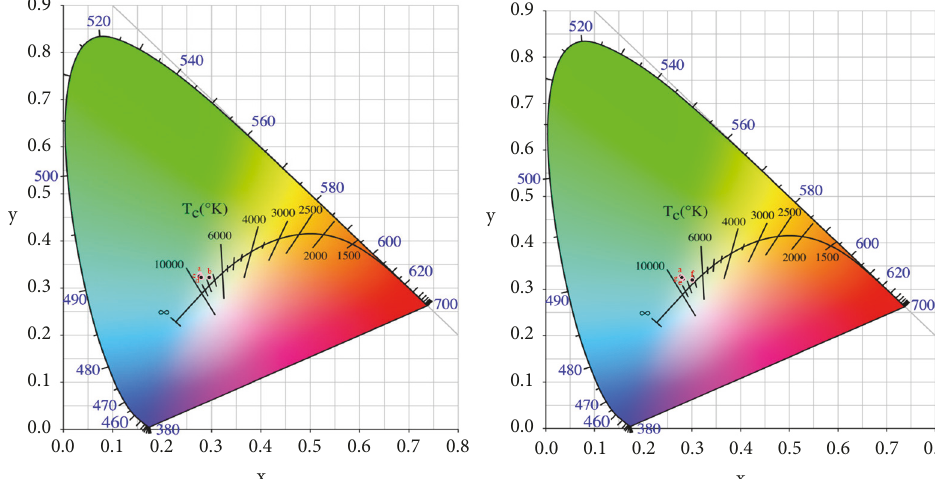
Figure 7: CIE chromaticity coordinates of La 0.97